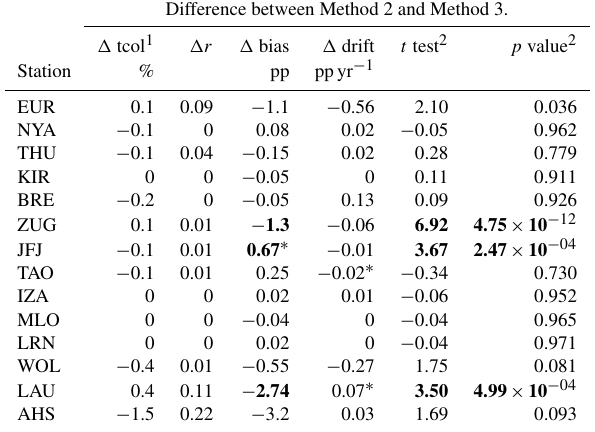
Table B2. Differences between validation results from the point- wise application of AKs and a priori profiles followed by averaging (Method 2) and mean AKs (Method 3). Differences are calculated between absolute values ( | Method 3 | – | Method 2 | ). Difference between Method 2 and Method